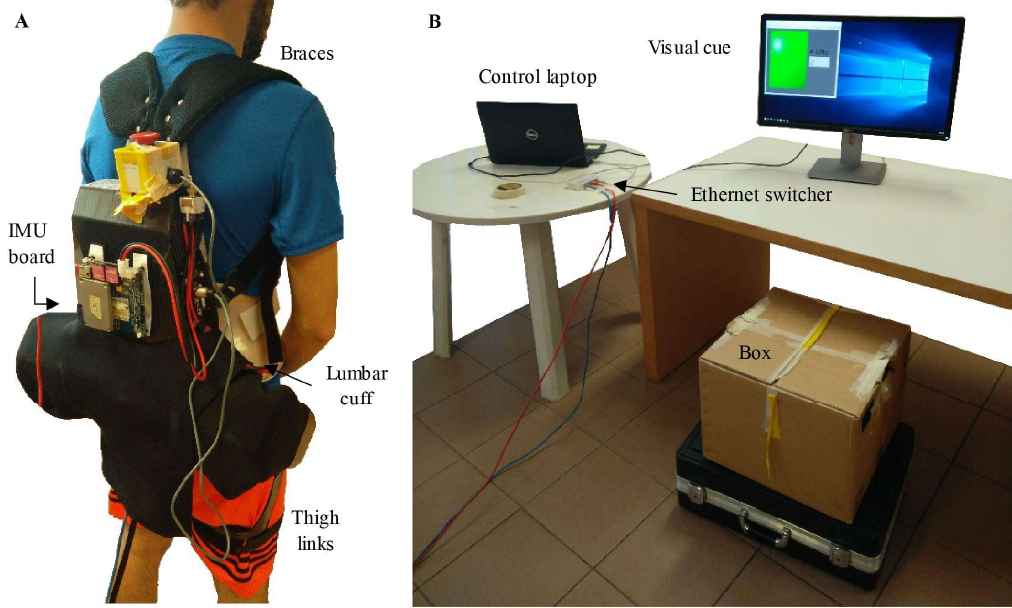
Figure 1. ( A ) A subject wearing the APO with an IMU board on the backpack. ( B ) Experimental setup of this study.